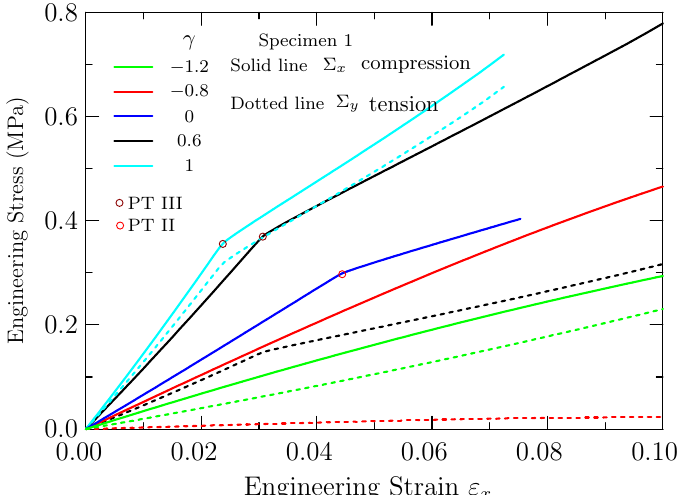
Figure 6. The engineering stress–strain responses for specimen 1 calculated at different biaxiality ratios. The critical points for the onset of "pattern transformation III" (PT III) or PT II are marked by dark-red or red circles on these curves. Pattern transformation III was only observed for specimen 1 with an oblique lattice of voids under biaxial compression. The solid lines and the dotted lines stand for the engineering stress Σ x in the direction of x and Σ y in the direction of y ,